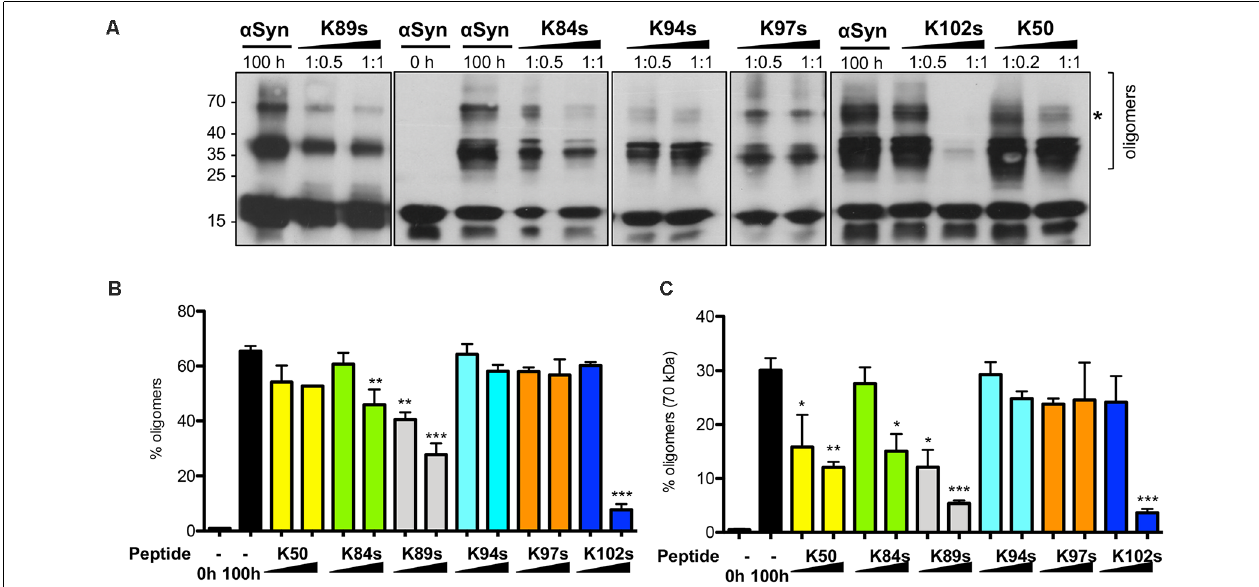
FIGURE 7 | Peptide-mediated reduction in α Syn oligomerization in vitro . (A) α Syn was incubated in the absence or presence of peptides in the indicated molar ratios. A sample at the initial time point (0 h) served as a control. Equal amounts of samples were collected after 100 h and analyzed by immunoblotting with the anti- α Syn antibody. (B) Densitometric analysis of the immunodetection of α Syn oligomeric species. The relative amount of α Syn oligomeric species was normalized to the total immunodetection/well. (C) The relative amount of higher molecular weight α Syn oligomeric species (70 kDa band, indicated with *), normalized to the total immunodetection/well. Significance of differences was calculated with t -test vs. α Syn without addition of peptides (black bars) (* p < 0.05; ** p < 0.01; *** p < 0.001; n = 3).